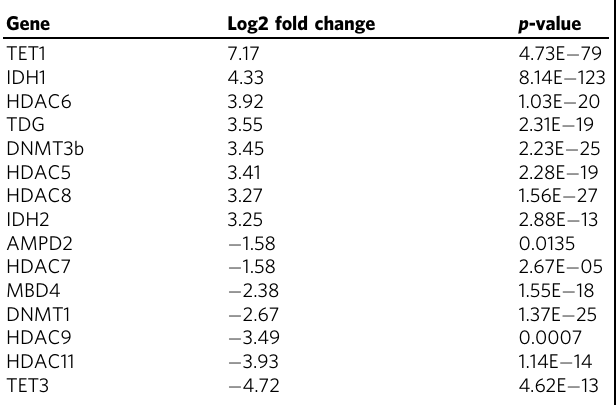
Table 1 Upregulated and downregulated genes related to DNA (de)methylation and histone (de)acetylation processes between G2 and G1 zygotes